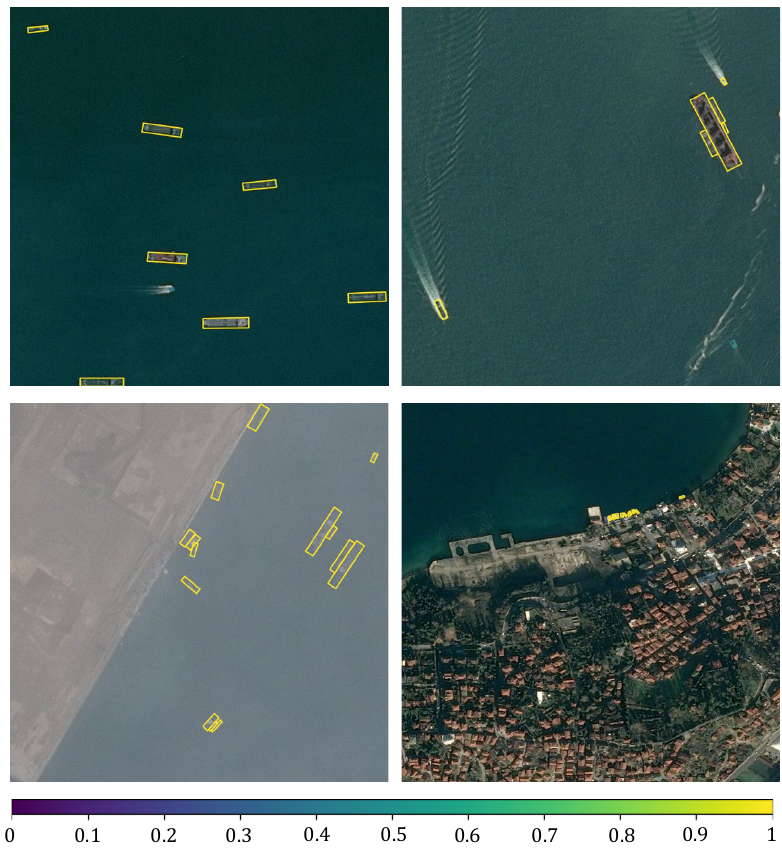
1 Figure 6. The detection results in tilted box on the Airbus ship dataset (the color of the detection box